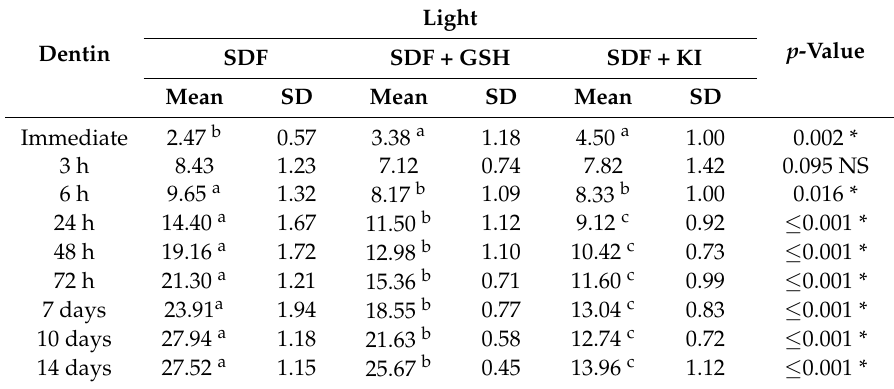
Table 3. Mean and SD for ΔE for different tested groups at all the time intervals within dentin under light exposed conditions.